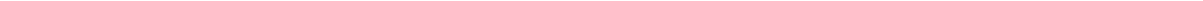
Fig. 6 ATRX directly binds to and represses HRAS in response to CDK4 inhibition. a Venn diagram indicating the number of ATRX-speci fi c summits identi fi ed by ChIP-sequencing performed in untreated (cycling) LS8817 cells, senescent LS8817 cells treated with either PD0332991 for 7 days (CDK4i) or doxorubicin for 7 days, and quiescent cells induced by growth in low serum for 5 days (0.5% serum starved). b Pie chart summarizing the distribution of the 166 senescence-speci fi c summits within gene bodies, associated with promoters or in intergenic regions. c Enrichr analysis of the top predicted transcription factors that regulate the “ gene body ” and “ promoter ” associated genes from b . d Expression of the indicated genes downregulated in senescence ( left ), or upregulated in senescence ( right ) in the cell lines treated with CDK4i was measured by qPCR and plotted as a fold change in treated (7 days) cells compared to untreated cells, normalized to β -actin. Dashed lines are drawn at 1.8 fold changes. e , f The expression of the indicated genes was measured in the indicated cell lines in which ATRX levels were manipulated ( e , LS8817; f , U2OS). g ATRX ChIP experiments were performed in untreated controls and PD0332991-treated cells and the relative binding of ATRX at the indicated loci was analyzed by qPCR. h ATRX ChIP was performed in LS8817 cells treated with PD0332991 at the indicated times and enrichment at the HRAS locus was determined by qPCR is plotted. i Genome browser view of ATRX enrichment at the HRAS locus under different growth conditions. The red bars below the tracks indicate the peaks called by the IDR algorithm. Green bars indicate sequences predicted to form G-quadruplex structures. Blue boxes represent the exonic structure of HRAS . Graphs are obtained from one of the two biologic ChIP-seq replicates but are representative of both. j ATRX was immunoprecipitated from CDK4 inhibitor treated and untreated U2OS cells in which either wild type (WT) or mutant proteins were expressed and enrichment at the HRAS locus determined by qPCR. k HRAS mRNA levels were measured in the cells described in Fig. 3. All data are represented as mean ± SEM from at least two independent experiments. Asterisk indicates p < 0.05 using a two-sided Student ’ s t-